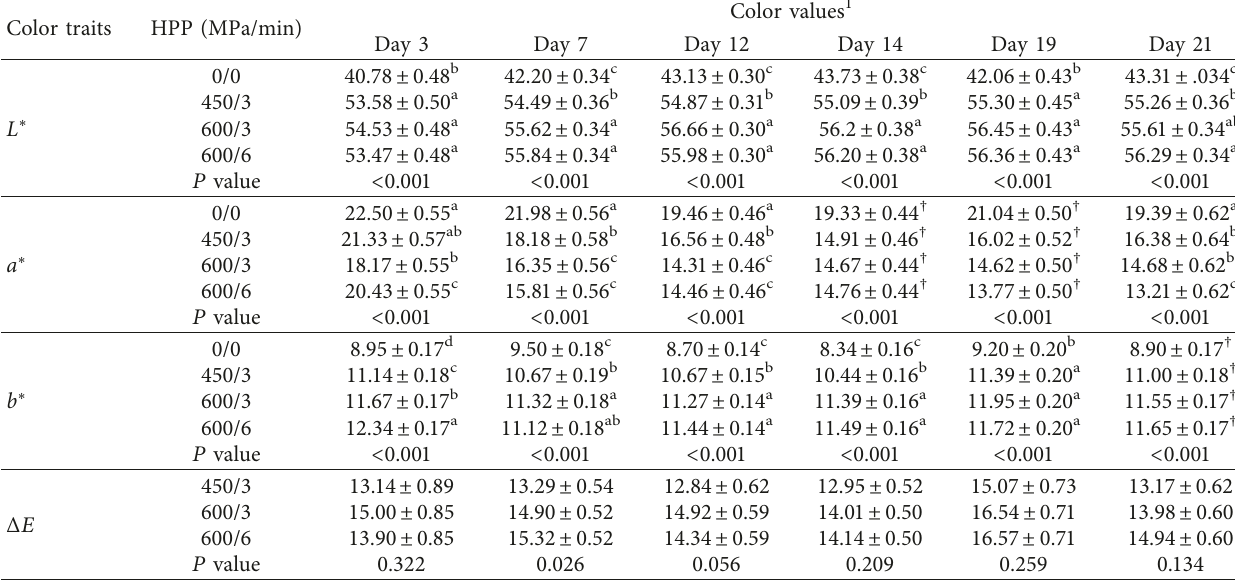
Table 1: Least square means ( ± SE) for main effect of high-pressure processing on color ( L ∗ , a ∗ , b ∗ ) and change in color ( Δ E ) during storage of ground beef patties. Color